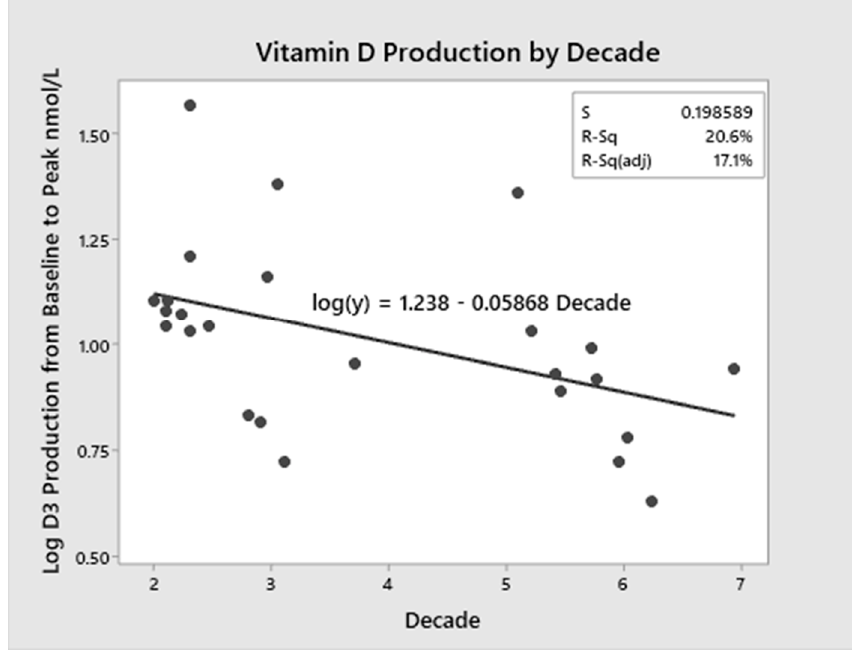
Figure 3. Vitamin D 3 Production and Age Model. The linear regression model with age as the independent variable and log D 3 production was constructed. Age accounted for 20% of the variance in D 3 production ( r 2 = 0.206).